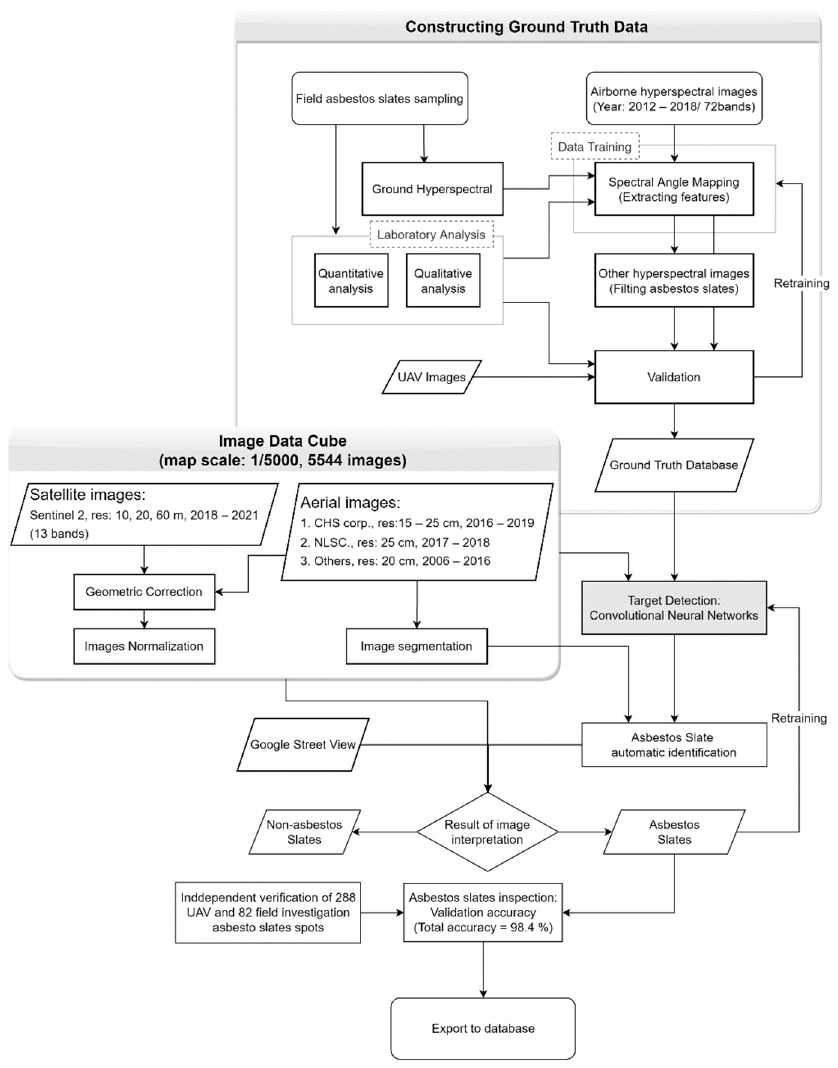
Figure 2. Flow chart and decision branches among various-origin data for this work.